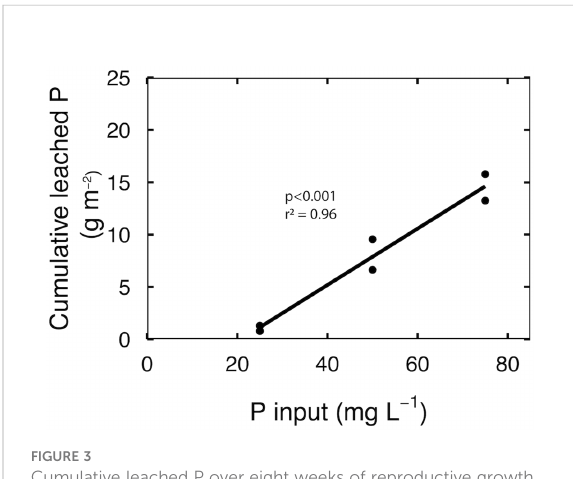
FIGURE 3 Cumulative leached P over eight weeks of reproductive growth at input P of 25, 50 and 75 mg per L. Each point represents the total leached P of a leachate collection tray that contained three separate containers.